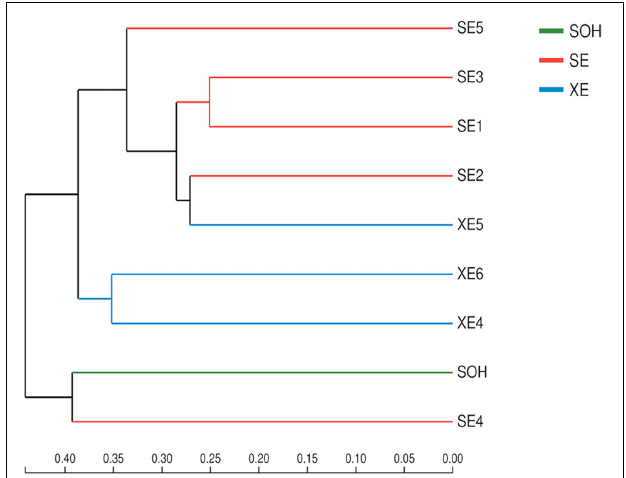
FIGURE 9 | A hierarchical cluster tree created using UPGMA with Bray–Curtis at the level of OTU. Microbial community distribution patterns at a 97%-similarity OTU level.